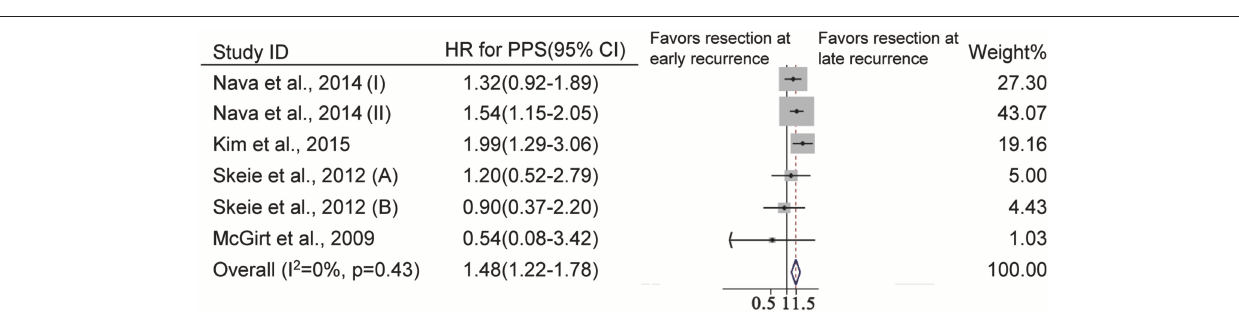
FIGURE 6 | Forest plots for post-progression survival analysis in patients undergoing reoperation after earlier recurrence vs. later